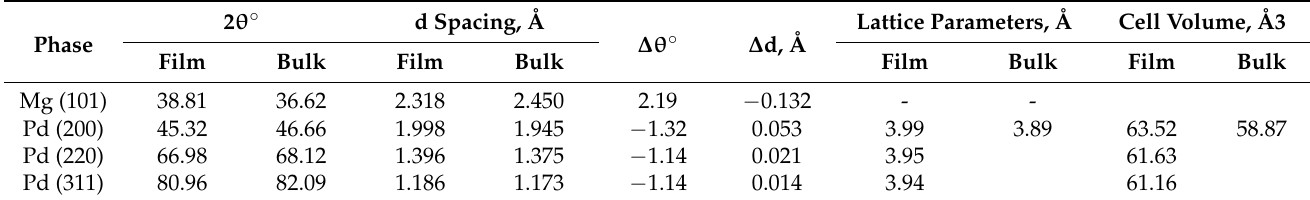
Table 1. Structure parameters of PdMg alloy.